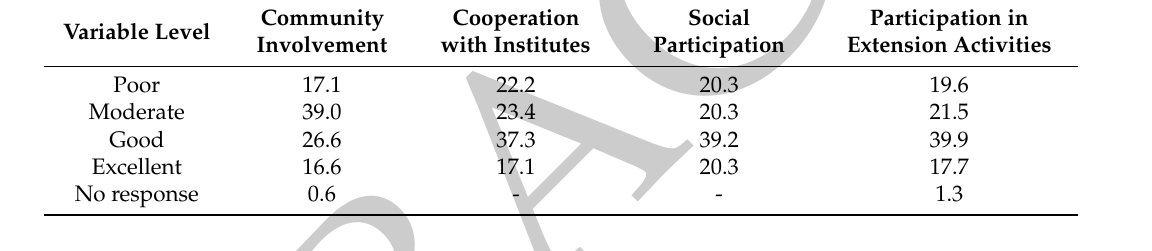
Table 2. Olive farmers’ social profile.